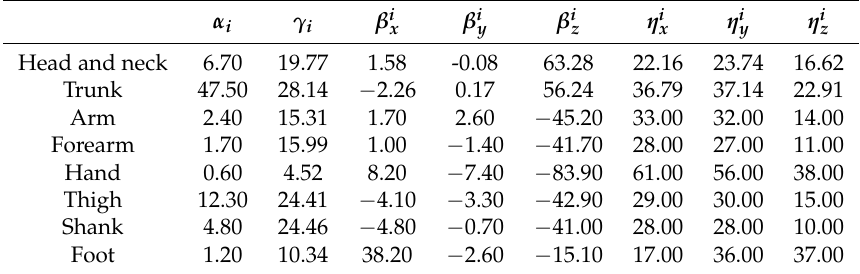
Table A5. McConville–Young–Dumas model parameters for each body segment.